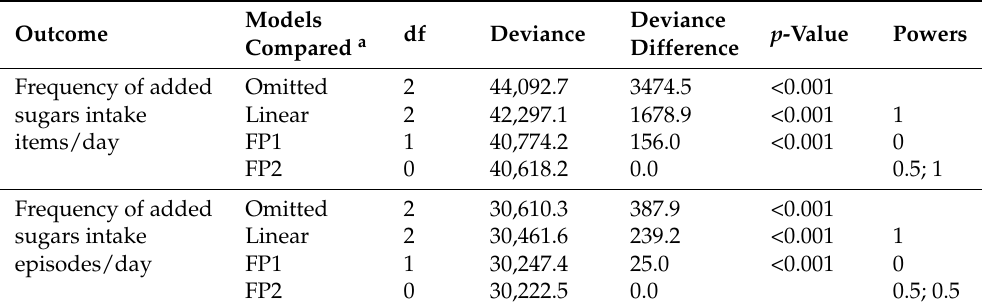
FP1: First-degree fractional polynomials; FP2: Second-degree fractional polynomials; df: degrees of freedom. a All models were adjusted by sex, categorical age, race/ethnicity, education, poverty income ratio, dental attendance pattern, and total energy intake.